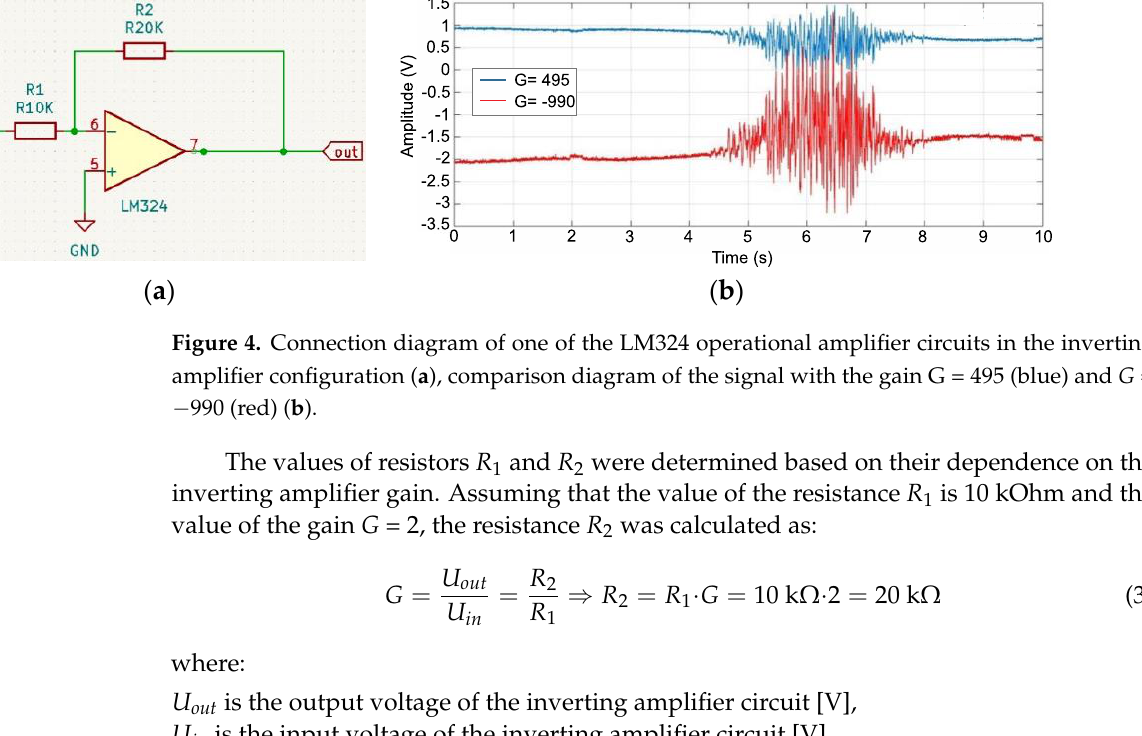
Figure 3. Scheme of connection of the instrumental amplifier circuit model AD620 ( a ), EMG biceps brachii signal amplified 495 times by the instrumental amplifier AD620ARZ ( b ).